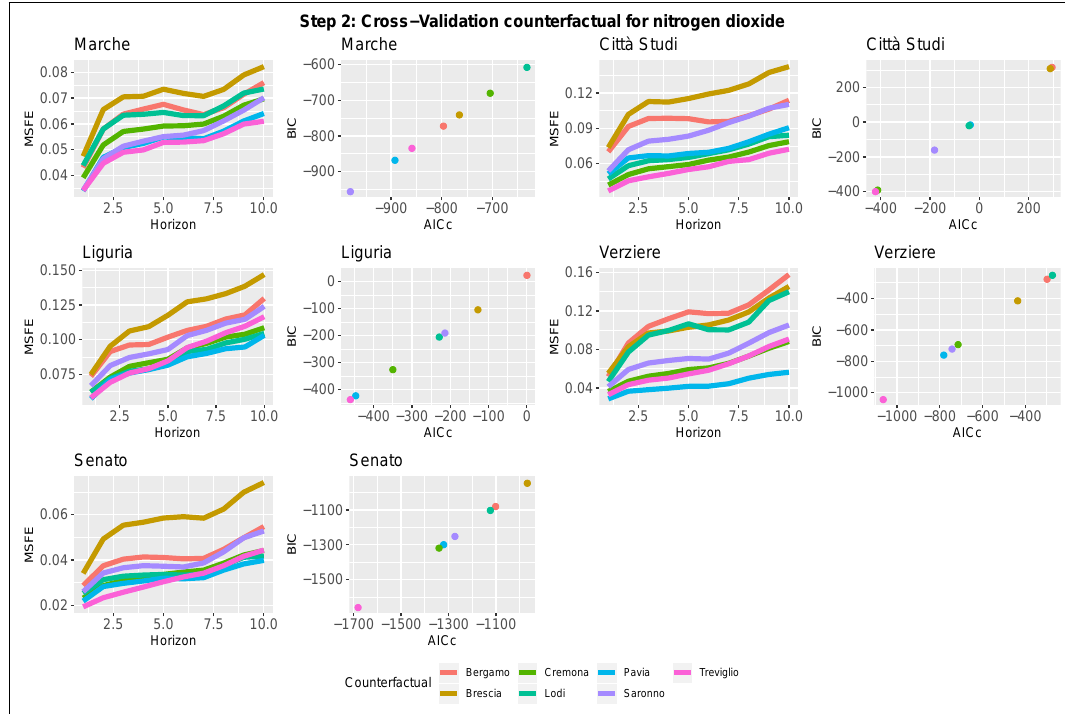
Figure 8. Model selection-Step 2-NO 2 . Counter-factual term selection for the five nitrogen dioxide stations in Milan. Left panel: 10-steps-ahead MSFE in log-scale as function of the candidate. Right panel: AICc and BIC pairs for each